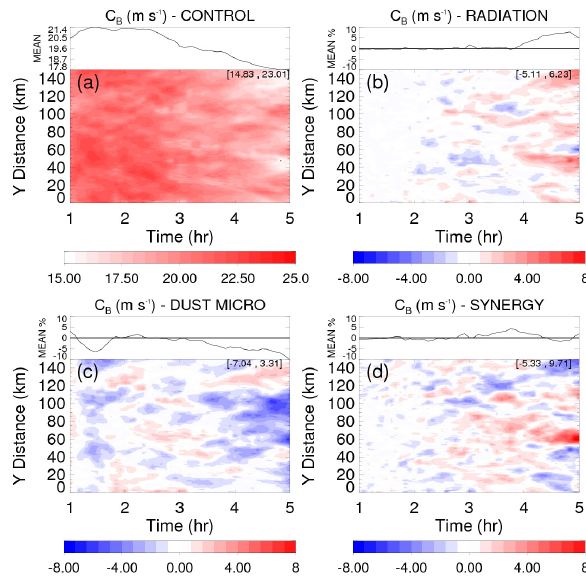
Fig. 5. Theoretical cold pool speed, which is defined in Eq. (1), shown for the four factors of (a) CONTROL, (b) RADIATION, (c) DUST MICRO, and (d) SYNERGY. The cold pool speed is ex- pressed as both a rotated Hovm¨oller diagram (shading) and a merid- ionally averaged time series that is expressed as a percent contribu- tion relative to CONTROL (line plot).